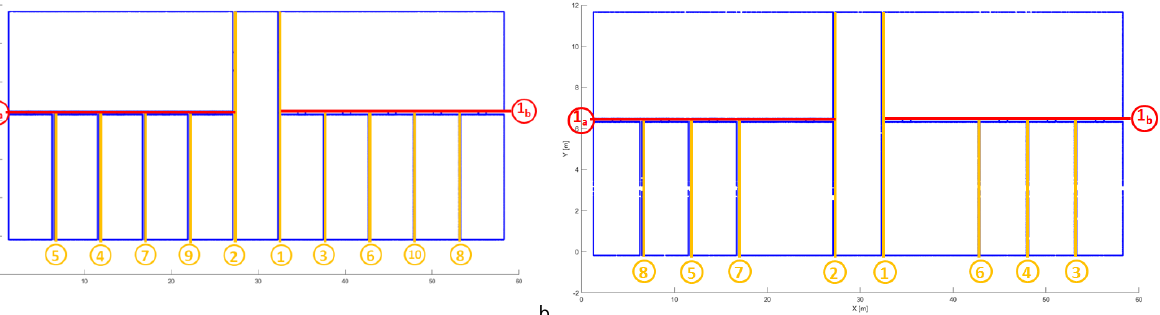
Figure 4. Building floorplan for Floor 1 (a) and Floor 2 (b) with insertion of the splitting planes numbered according to the sequence